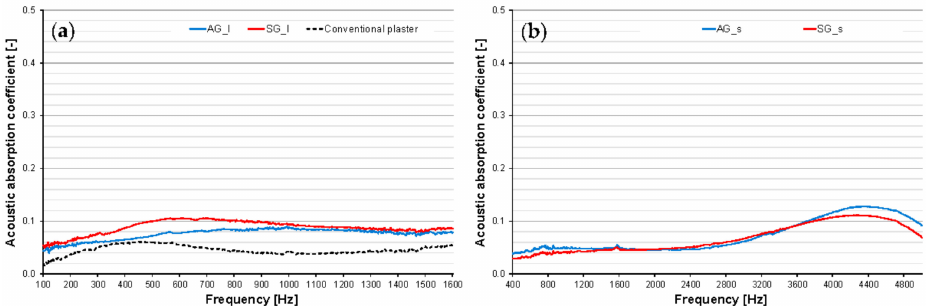
Figure 10. Normal incidence absorption coe ffi cient of AG and SG samples: ( a ) large tube (100–1600 Hz) and ( b ) small tube (400–5000 Hz) measurements.